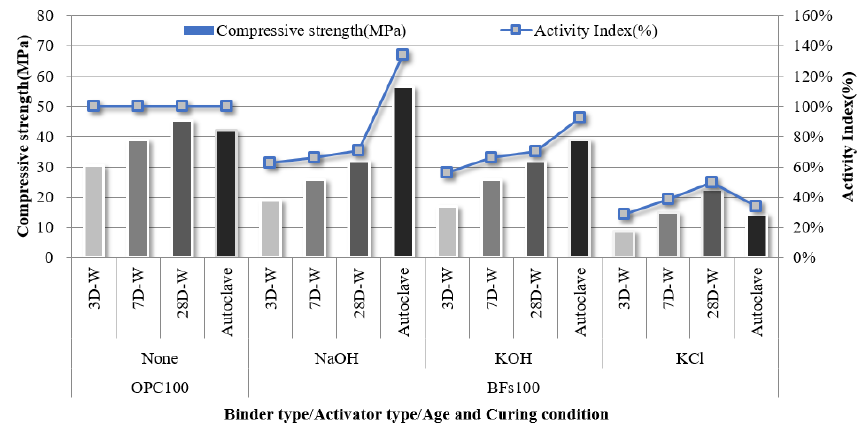
Figure 4. Compressive strength and activity index of the 100% BFS mortar sample with KCl separated from CBD, NaOH, and KOH as activators.